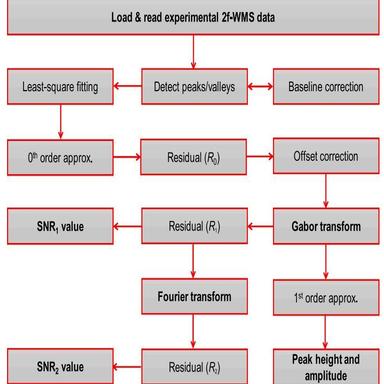
Flow chart representing digital 2f-WMS signal processing including line-shape fitting and calculation of SNR parameters.